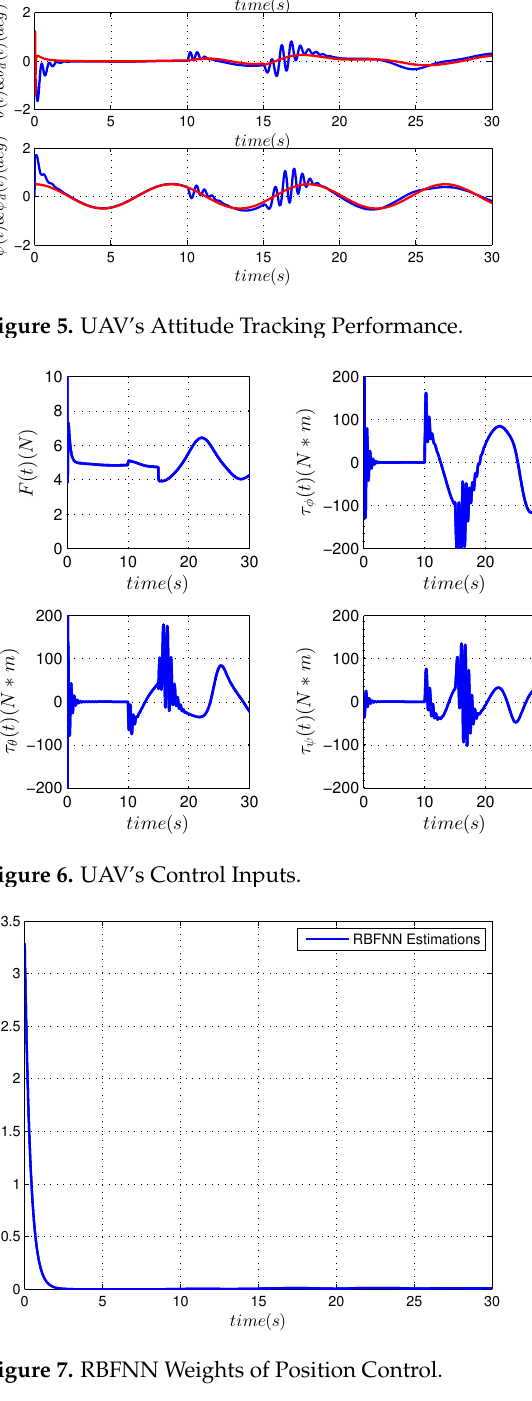
Figure 7. RBFNN Weights of Position